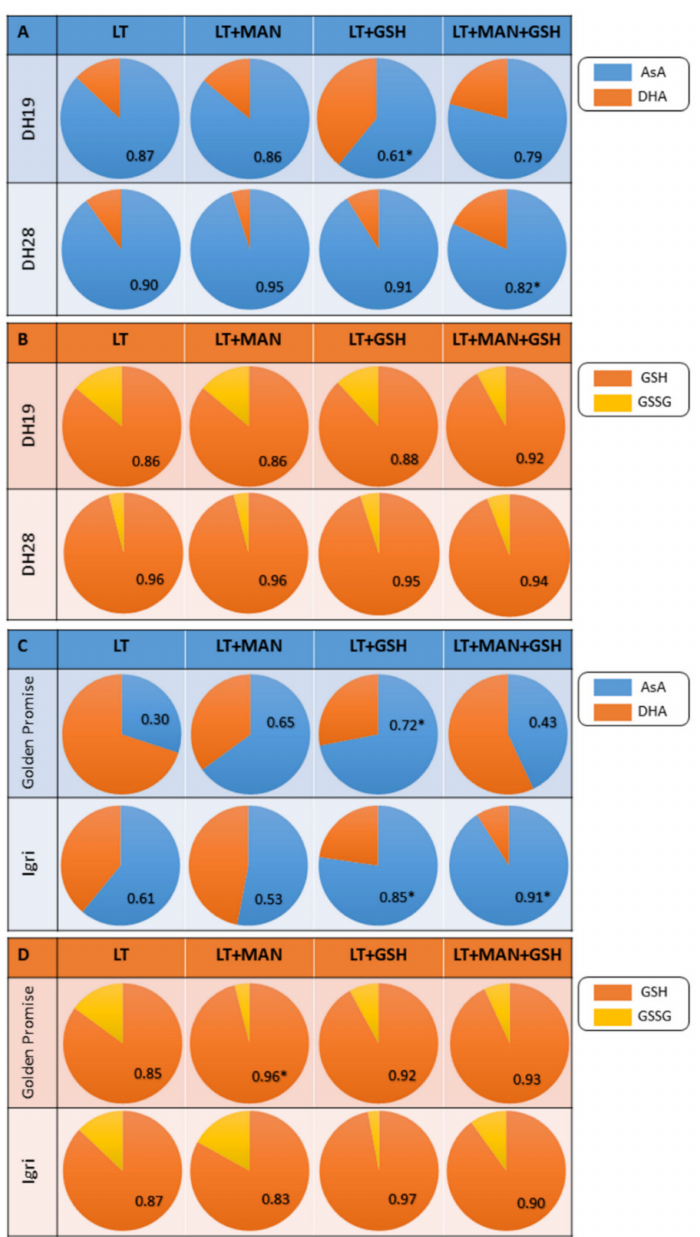
Figure 3. The proportion reduced (ASC, GSH) and oxidized (DHA, GSSG) forms of ascorbate and glutathione in their total pools in microspores of two DH triticale lines (responsive DH28 and recalcitrant DH19) ( A , B ) and two barley cultivars (responsive cv. Igri and recalcitrant cv. Golden Promise) ( C , D ) isolated after various tiller pre-treatments. The numbers represent the redox status of ascorbate (ASC/ASC+DHA) and glutathione (GSH/GSH+GSSG). Values significantly different from control (LT) according to the Kruskal–Wallis test (* p ≤ 0.001) are marked with an asterisk. LT—low temperature tiller pre-treatment (21 days at 4 ◦ C); LT+MAN—low temperature tiller pre- treatment combined with the application of 0.3 M mannitol; LT+GSH—low temperature tiller pre- treatment combined with the application of 0.3 mM reduced glutathione; LT+MAN+GSH—low temperature tillers pre-treatment combined with the application of 0.3 M mannitol and 0.3 mM reduced